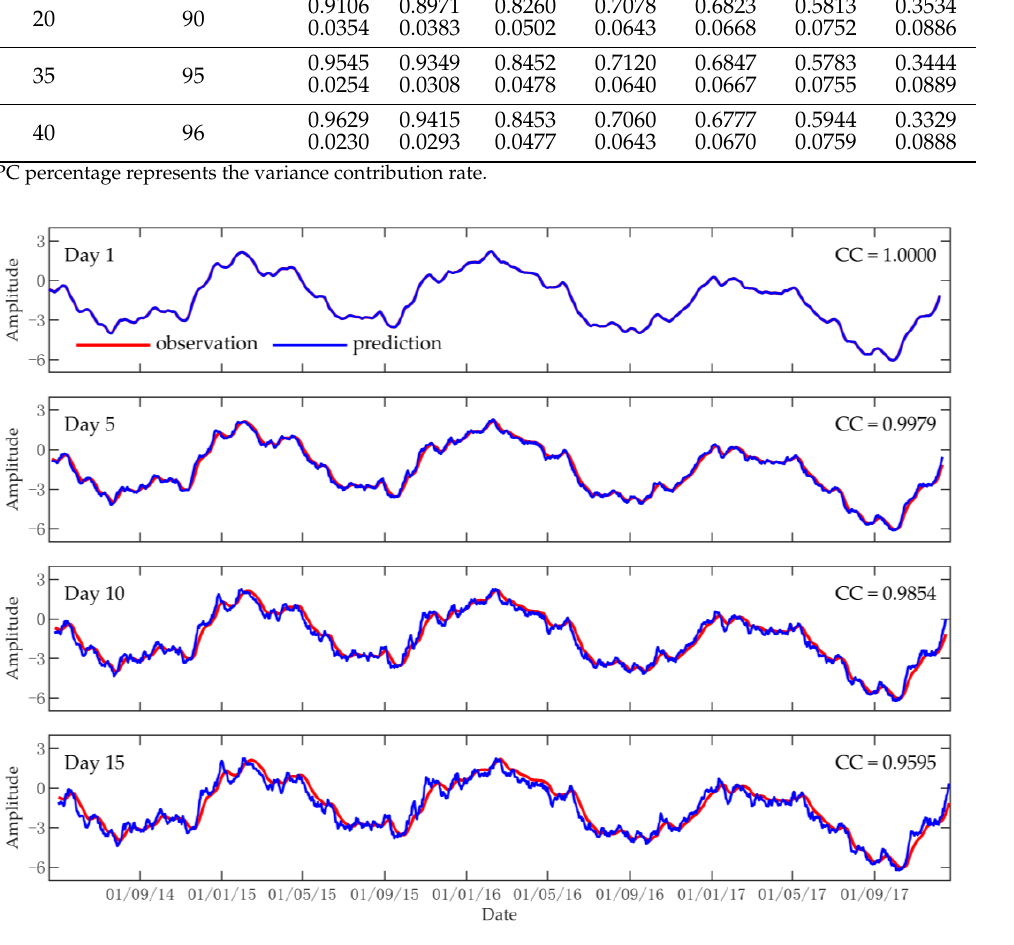
Figure 5. The comparison of the first PCs of the observed (red) and predicted (blue) SLA of the study area from 18 April 2014 to 31 December 2017. The upper left of the figures shows the number of forecast days. The correlation coefficient is at the top right of the figures.